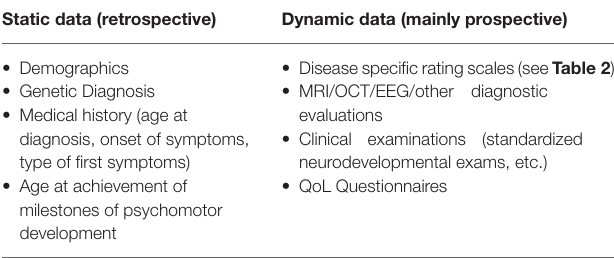
TABLE 1 | Overview of types of data (static/retrospective, dynamic/prospective). Static data (retrospective) Dynamic data (mainly